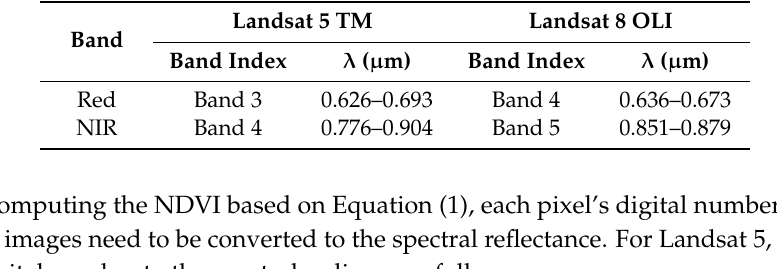
Table 1. The Landsat spectral bands used for computing NDVI.